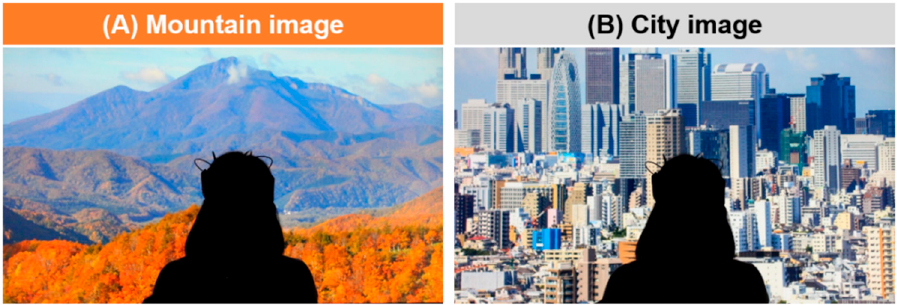
Figure 2. Images used in visual exposure. ( A ) Mountain image: Mount Bandai autumn landscape, Fukushima. ( B ) City image: Skyscraper landscape in Shinjuku, Tokyo.